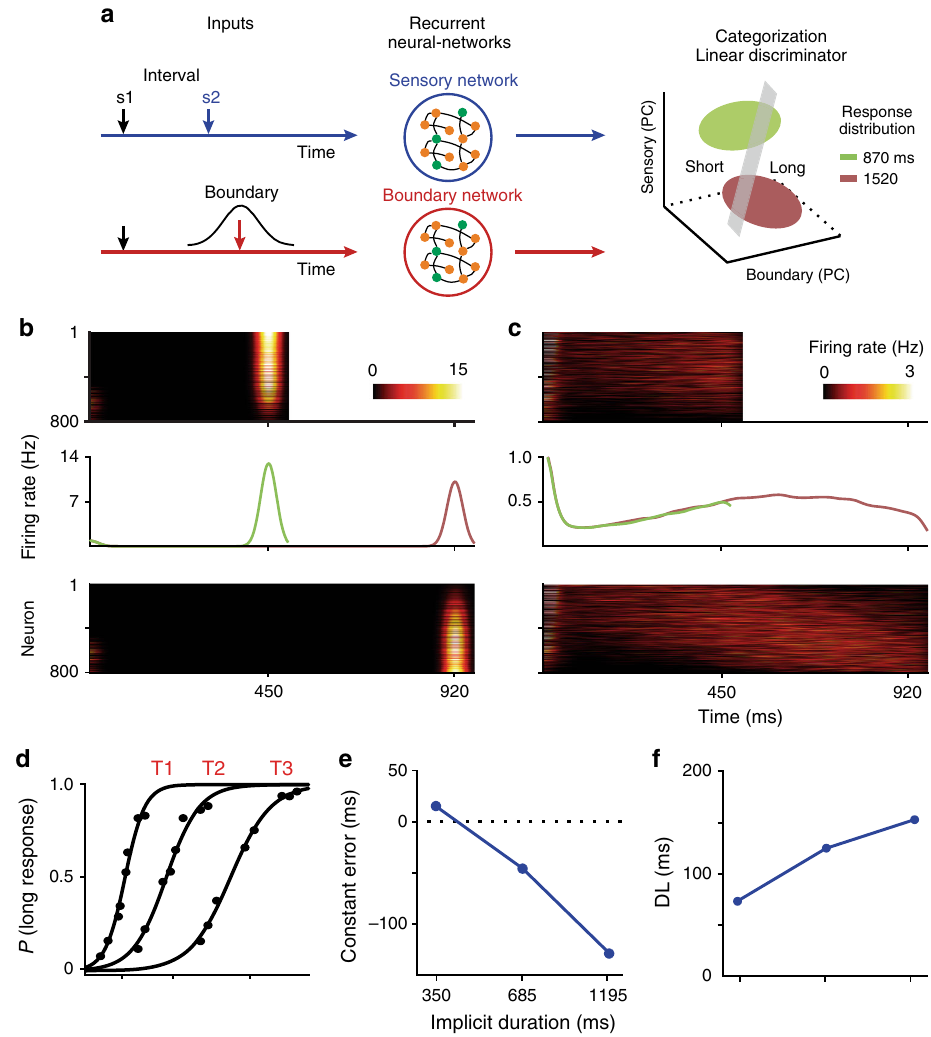
Fig. 6 A neural-network model of boundary cells generating categorical signals. a Center panel, the model consisted of an independent sensory and a boundary recurrent network whose outputs were read by a linear classi fi er. Each network consisted of 800 excitatory and 200 inhibitory neurons. Left panel, the sensory network received an input comprising of two pulses (s1 and s2) separated by a test interval, whereas the boundary network received a set of pulses with intervals coming from a Gaussian distribution, simulating boundary input responses. The pulses modulated the activity of each network cell through two input current types: AMPA, which induced facilitation, and GABAb, which corresponded to a slow inhibitory current. Right panel, PCA was used to project the pro fi le of neural activation of the sensory and boundary networks onto three dimensions (X = Boundary PC1, Y = Boundary PC2, Z = Sensory PC1). A linear classi fi er (gray plane) was used to fi nd the plane in the PCA space that could divide short and long intervals according to the psychometric performance of the monkey. Thus, the proportion of simulations (green ellipse for shorter interval and brown ellipse for long interval) that was to the right of the discrimination plane was considered short, while the proportion to the left was considered long. b Temporal pattern of activity of the sensory network population during the presentation of a short and a long interval (upper and lower panels, respectively). After the presentation of the second pulse, at 450 or 920 ms, the network presented a large phasic activation. The mean population fi ring rate is indicated in the middle panel. c Temporal pattern of activity of the boundary network population during the presentation of the same short and long intervals of ( b ) (upper and lower panels, respectively). When the longest interval was presented, the population of cells in the boundary network generated an up – down pro fi le of activation. d Networkmetric curves generated by the model. The probability of long categorization was computed from the linear classi fi er in a right. e Constant error and f DL produced by the model for the three blocks of stimuli employed in the time categorization